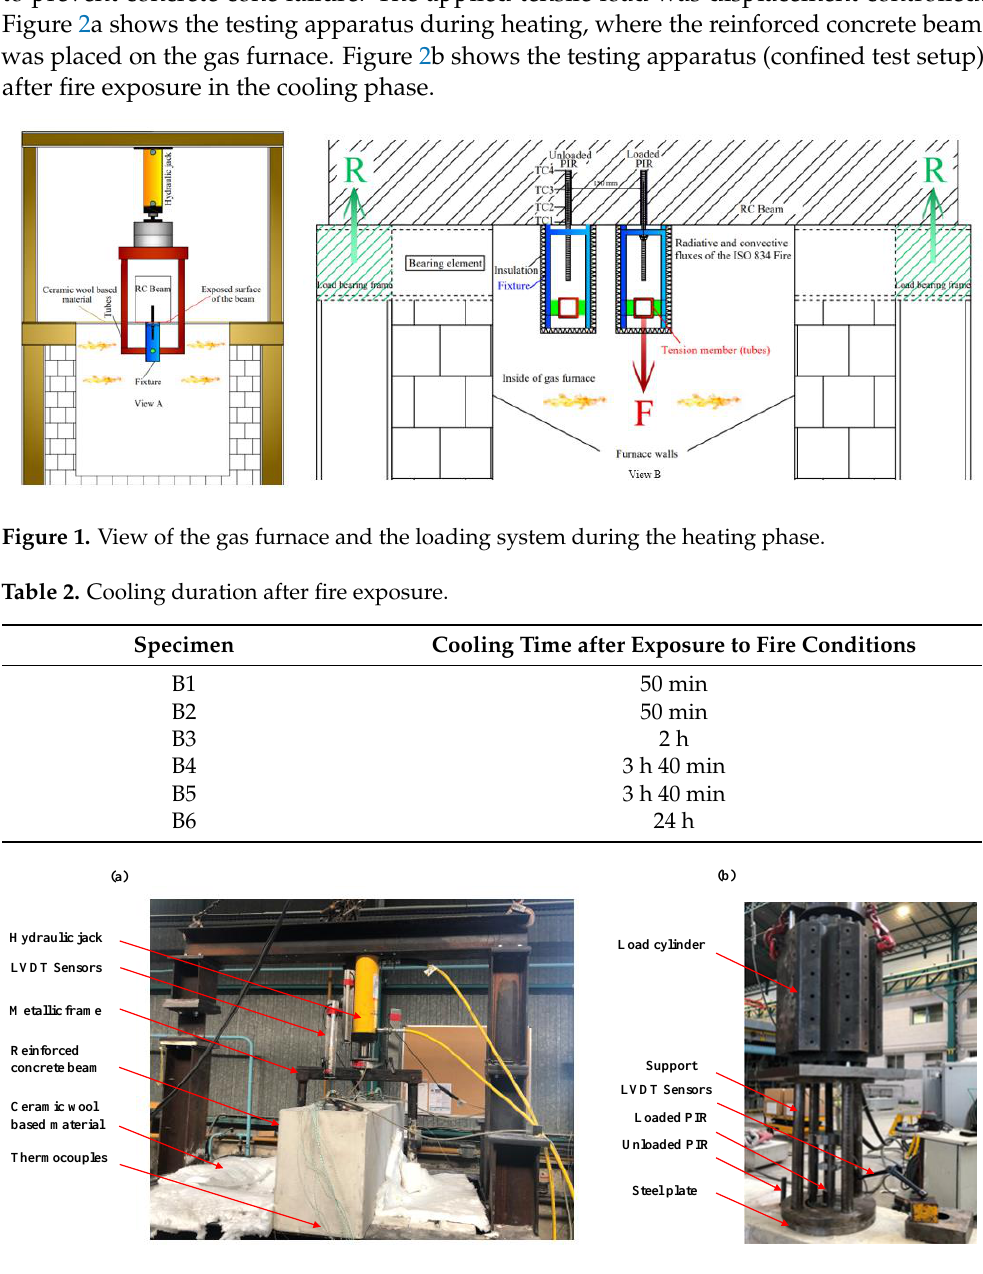
Figure 2. Testing apparatus in the heating phase ( a ) and the cooling phase ( b ).